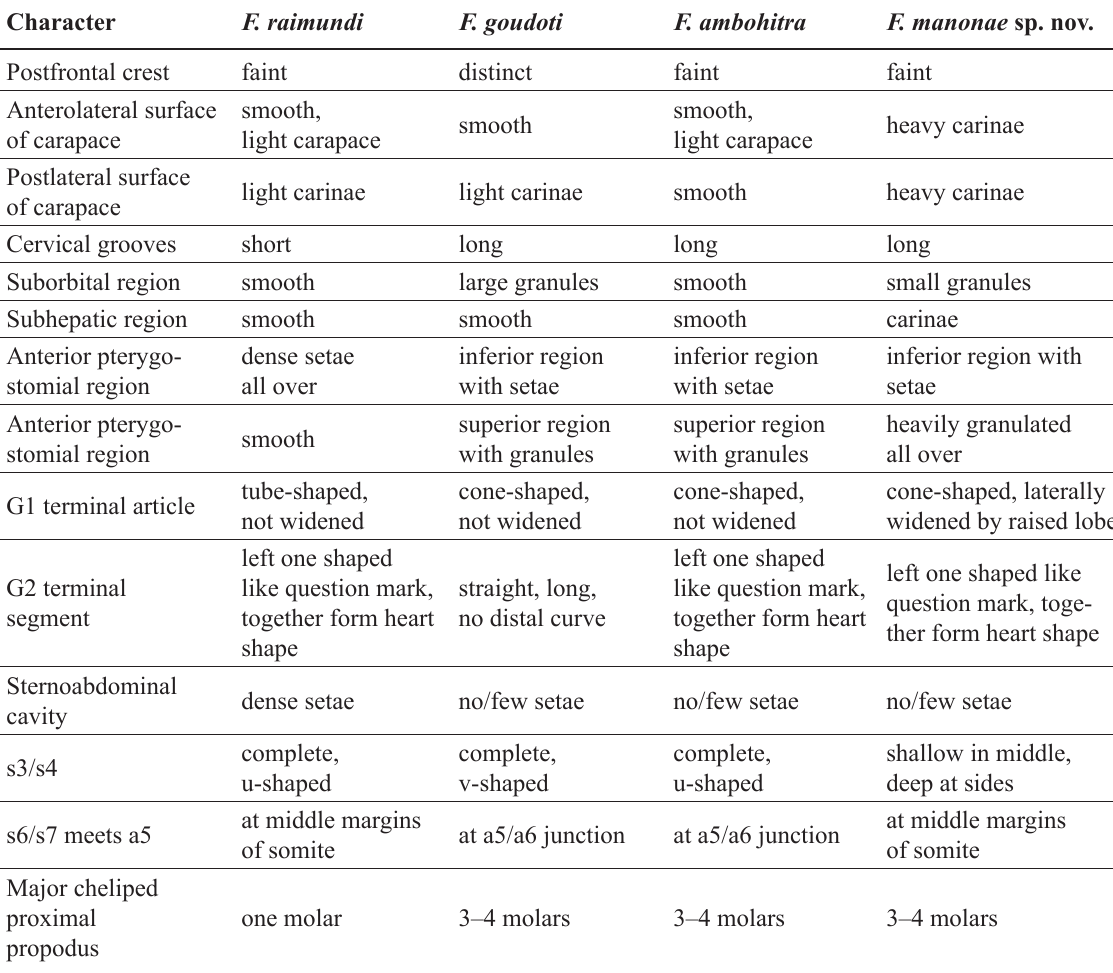
Table 1. Comparison of the morphological characters of the species in the genus Foza